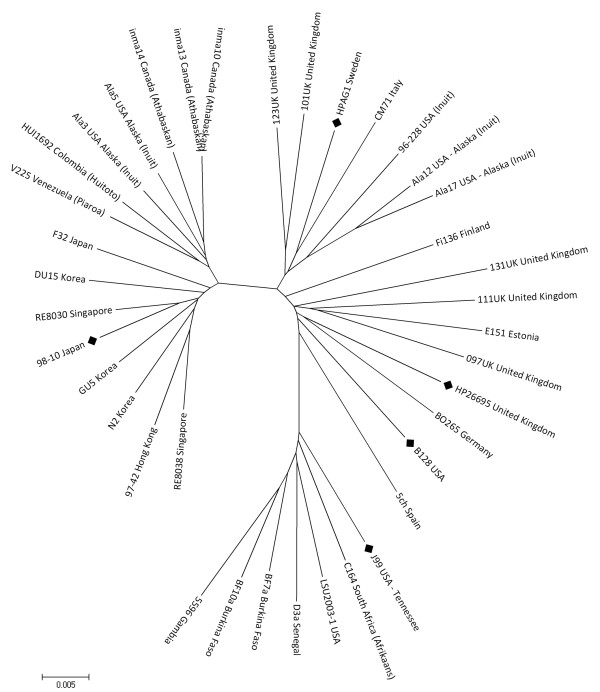
Phylogenetic structure based on sequence analysis of 8 H. pylori core genes. H. pylori strains analyzed in this figure include strains 98-10, B128, three strains for which genome sequences were previously determined (26695, J99, HPAG1), and representative strains isolated from patients in diverse geographic locations [18]. The figure lists the strain designations and the countries where strains were isolated. The nucleotide sequences of the concatenated MLST loci were aligned and compared, as described in Methods. All positions containing gaps and missing data were eliminated from the dataset. There were a total of 3041 positions in the final dataset. Neighbor-joining trees were constructed based on distances estimated by the Kimura 2-parameter model of nucleotide substitution [57,58]. The bootstrap consensus tree inferred from 1000 replicates is taken to represent the evolutionary history of the strains analyzed [59]. Branches corresponding to partitions reproduced in fewer than 50% bootstrap replicates are collapsed. The tree is drawn to scale, with the branch lengths in the same units as those of the evolutionary distances used to infer the phylogenetic tree. Phylogenetic analyses were conducted in MEGA4 [63]. Five H. pylori strains for which genome sequences were available are denoted by diamonds. Three main H. pylori population groups (East Asian, European, and West African) are identifiable.